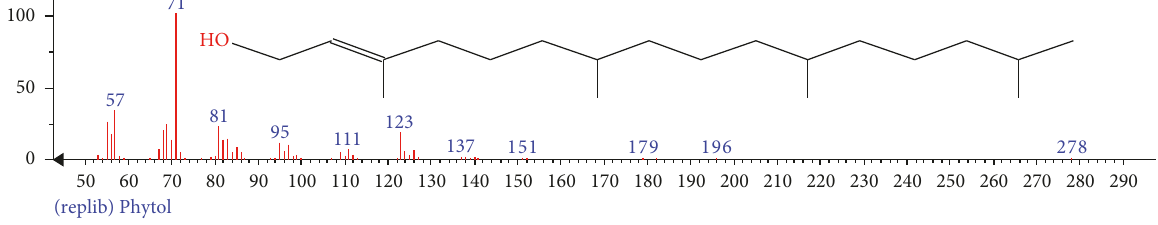
Figure 41: Mass spectrum of compound phytol of whole plant hexane fraction of Achillea wilhelmsii (WHFAW).